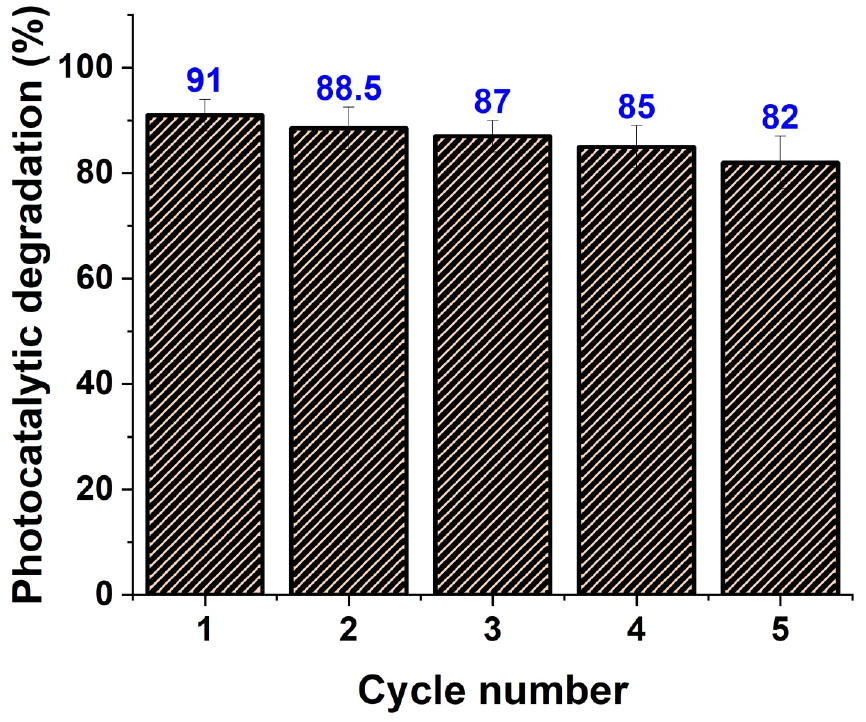
Figure 9. The usability of Ag-doped ZnO/MWCNTs as a catalytic degradable material against RhB.